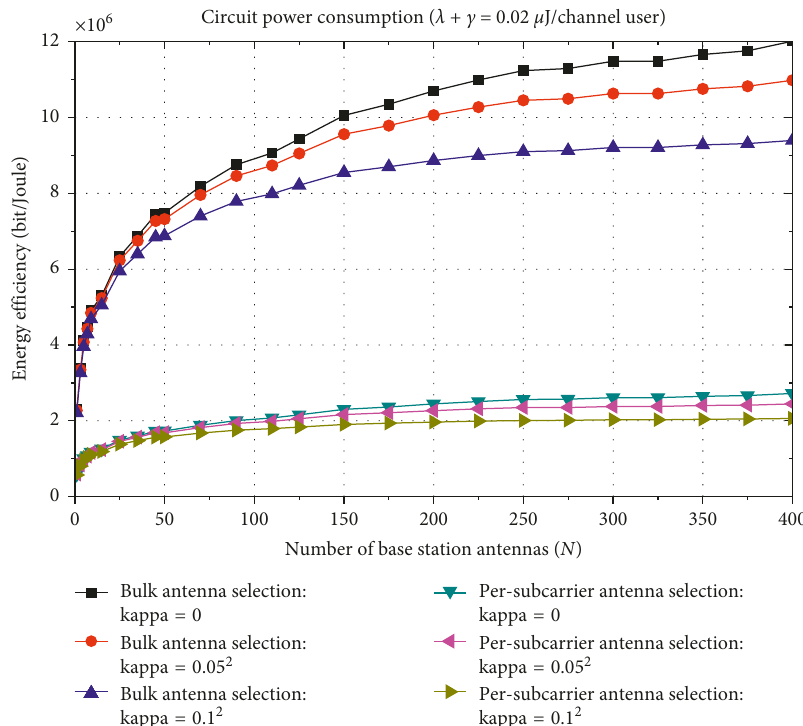
Figure 3: Energy efficiency of the massive MIMO-OFDM channel versus the number of BSA for per-subcarrier selection and bulk antenna selection techniques using various hardware impairments (kappa